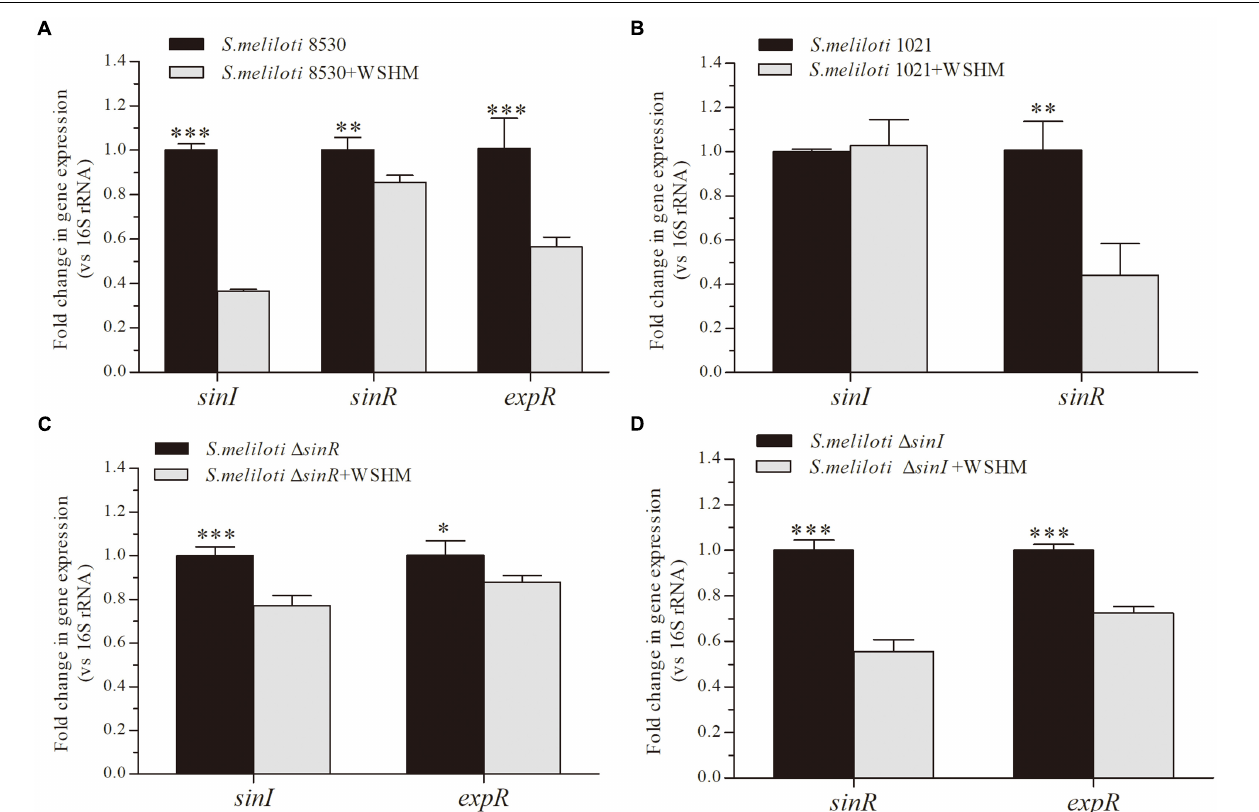
FIGURE 3 | Effects of WSHM on the expression of genes involved in the QS system in S. meliloti 8530 (A) , S. meliloti 1021 (B) , S. meliloti (cid:49) sinR (C) , and S. meliloti (cid:49) sinI (D) . Data are expressed as average ± SD ( n = 3). Statistical significance was determined using Student’s t -tests ( ∗ P < 0.05; ∗∗ P < 0.01; ∗∗∗ P <